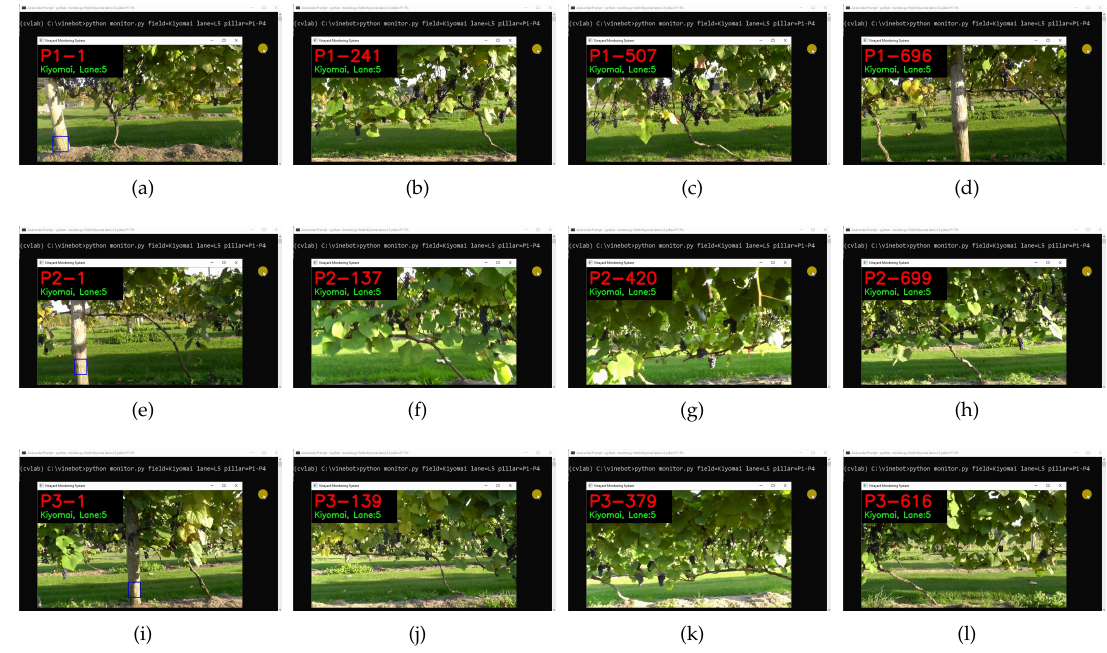
Figure 13. Output of monitoring software for command: field = Kiyomailane = L5pillar = P1 − P4: ( a ) initial image from Pillar 1; ( b , c ) intermediate images; ( d ) last image from Pillar 1; ( e ) initial image from Pillar 2; ( f , g ) intermediate images; ( h ) last image from Pillar 2; ( i ) initial image from Pillar 3; ( j , k ) intermediate images; and ( l ) last image from Pillar 3. Please see the video provided in the Supplementary